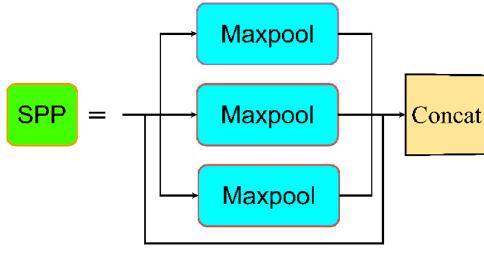
Figure 5. SPP unit module.